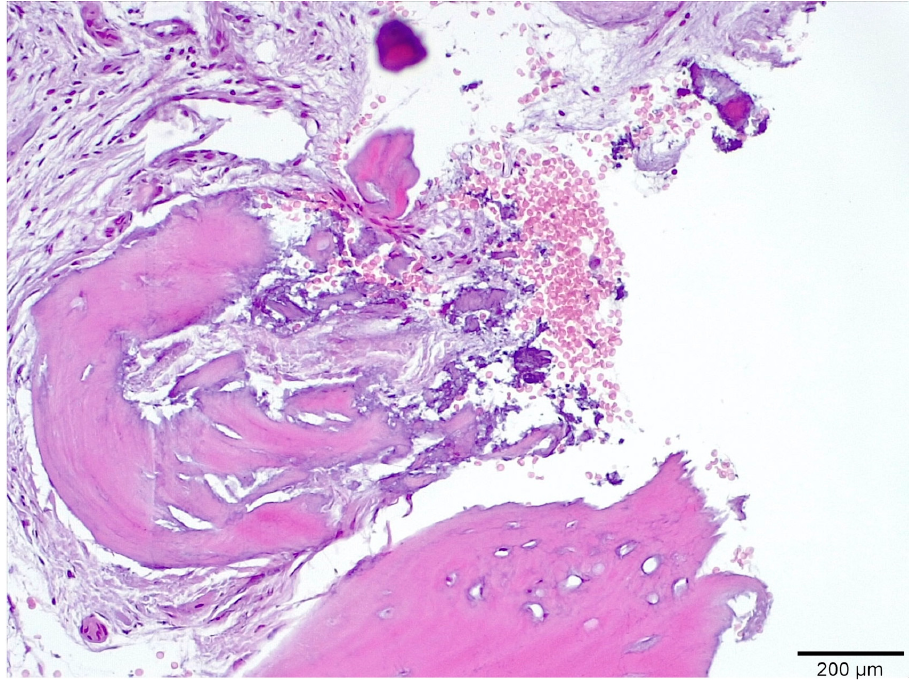
Figure 9. Dentin particles and a big structure of bone, with a small amount of soft tissue.